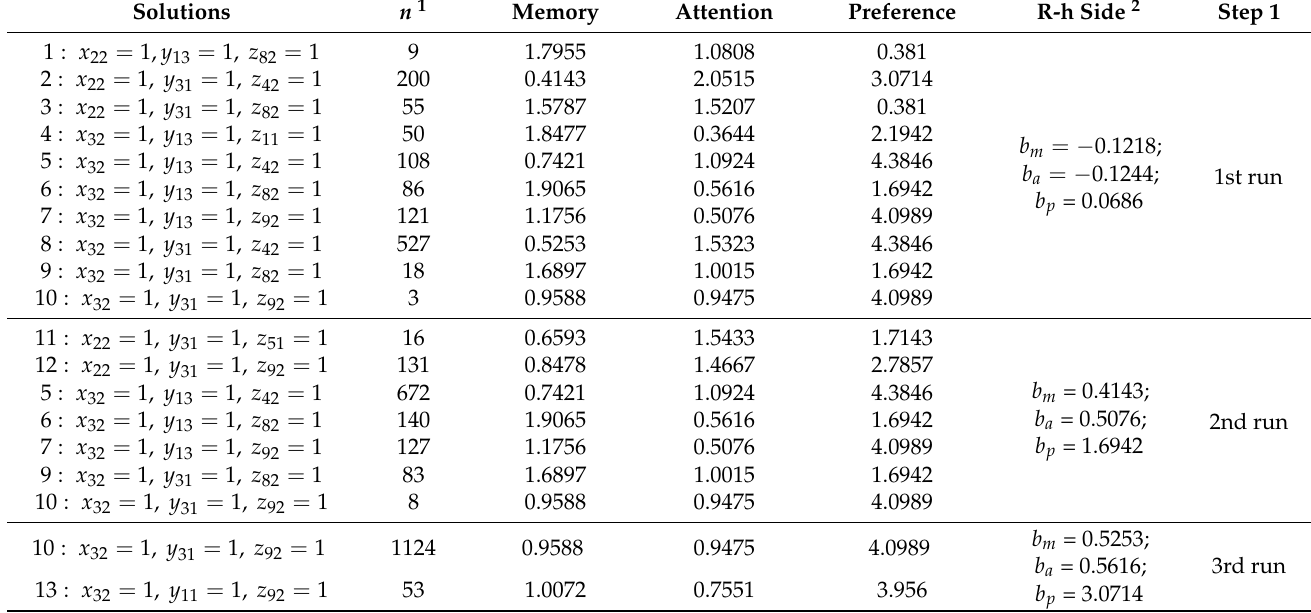
Table 5. Set of efficient solutions obtained with the heuristic.